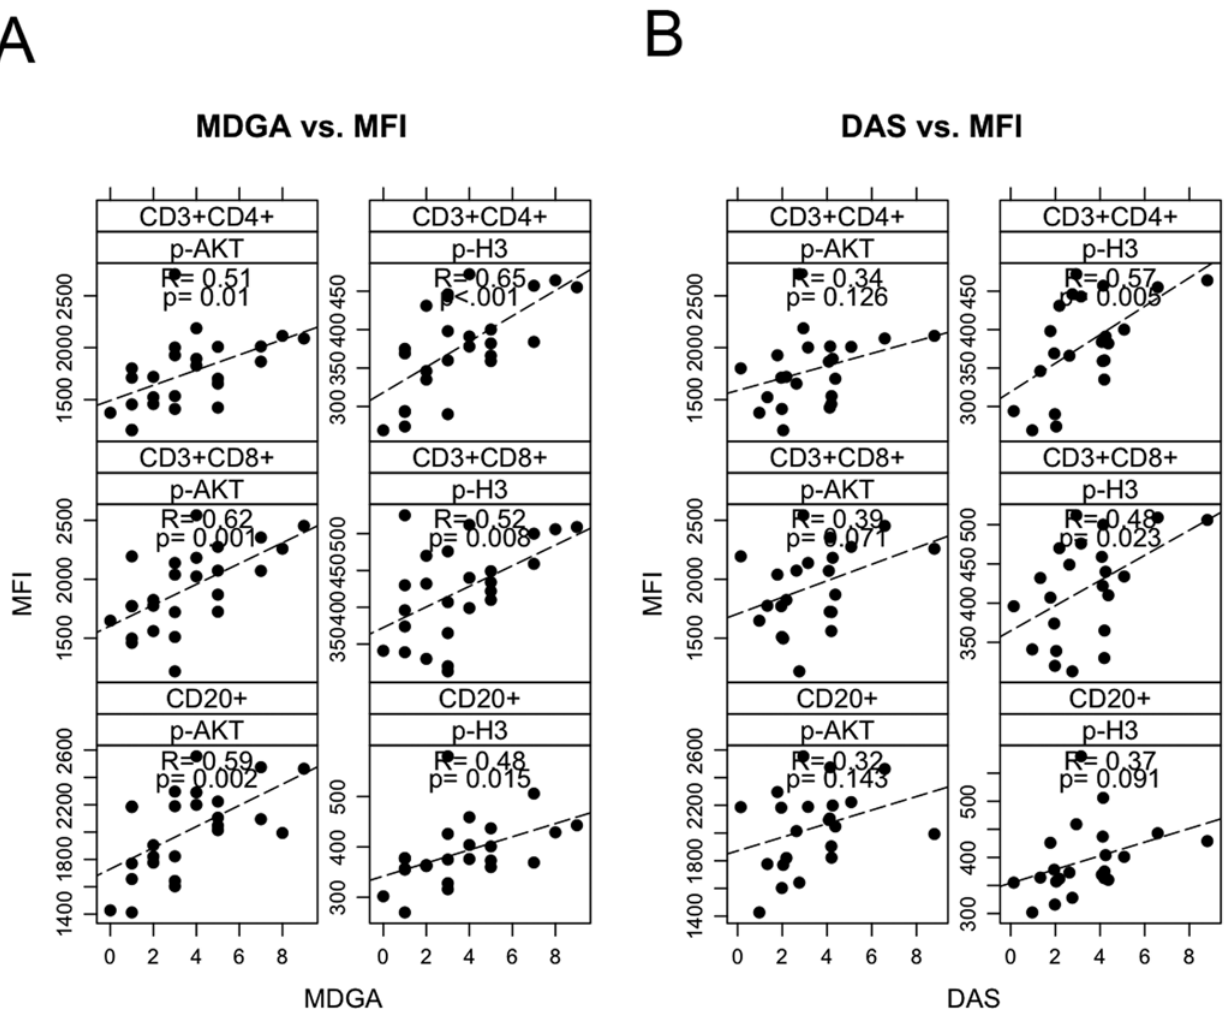
Figure 5. The extent of phosphorylation of H3 and AKT correlates with the MDGA score and DAS28 in ERA PBMC. Dot plots of (A) MDGA vs p-H3 MFI values (n=32) and (B) MDGA vs p-AKT MFI values (n=32) in the CD4, CD8 and CD20 cell populations of ERA patient